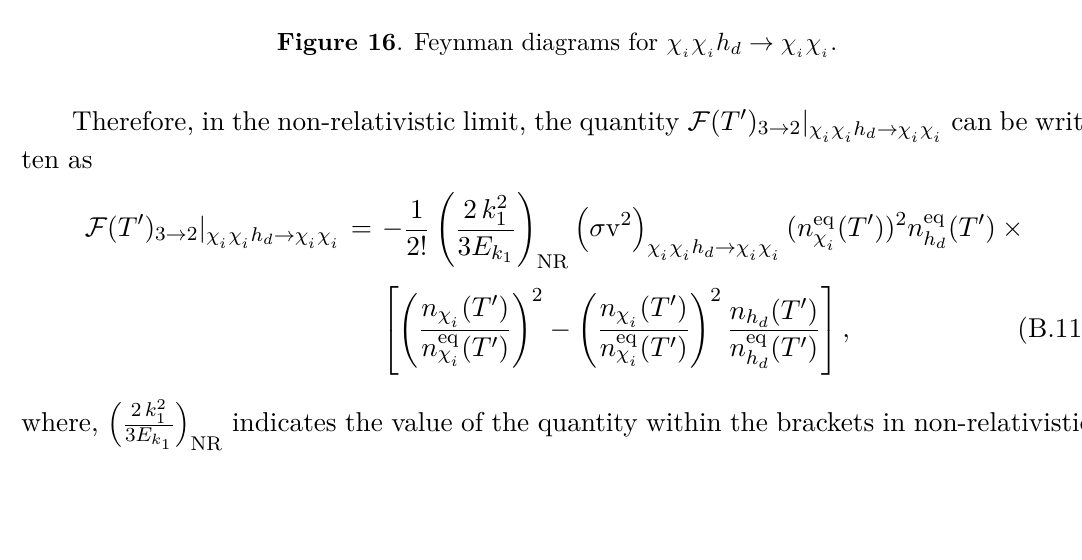
Figure 16 . Feynman diagrams for χ